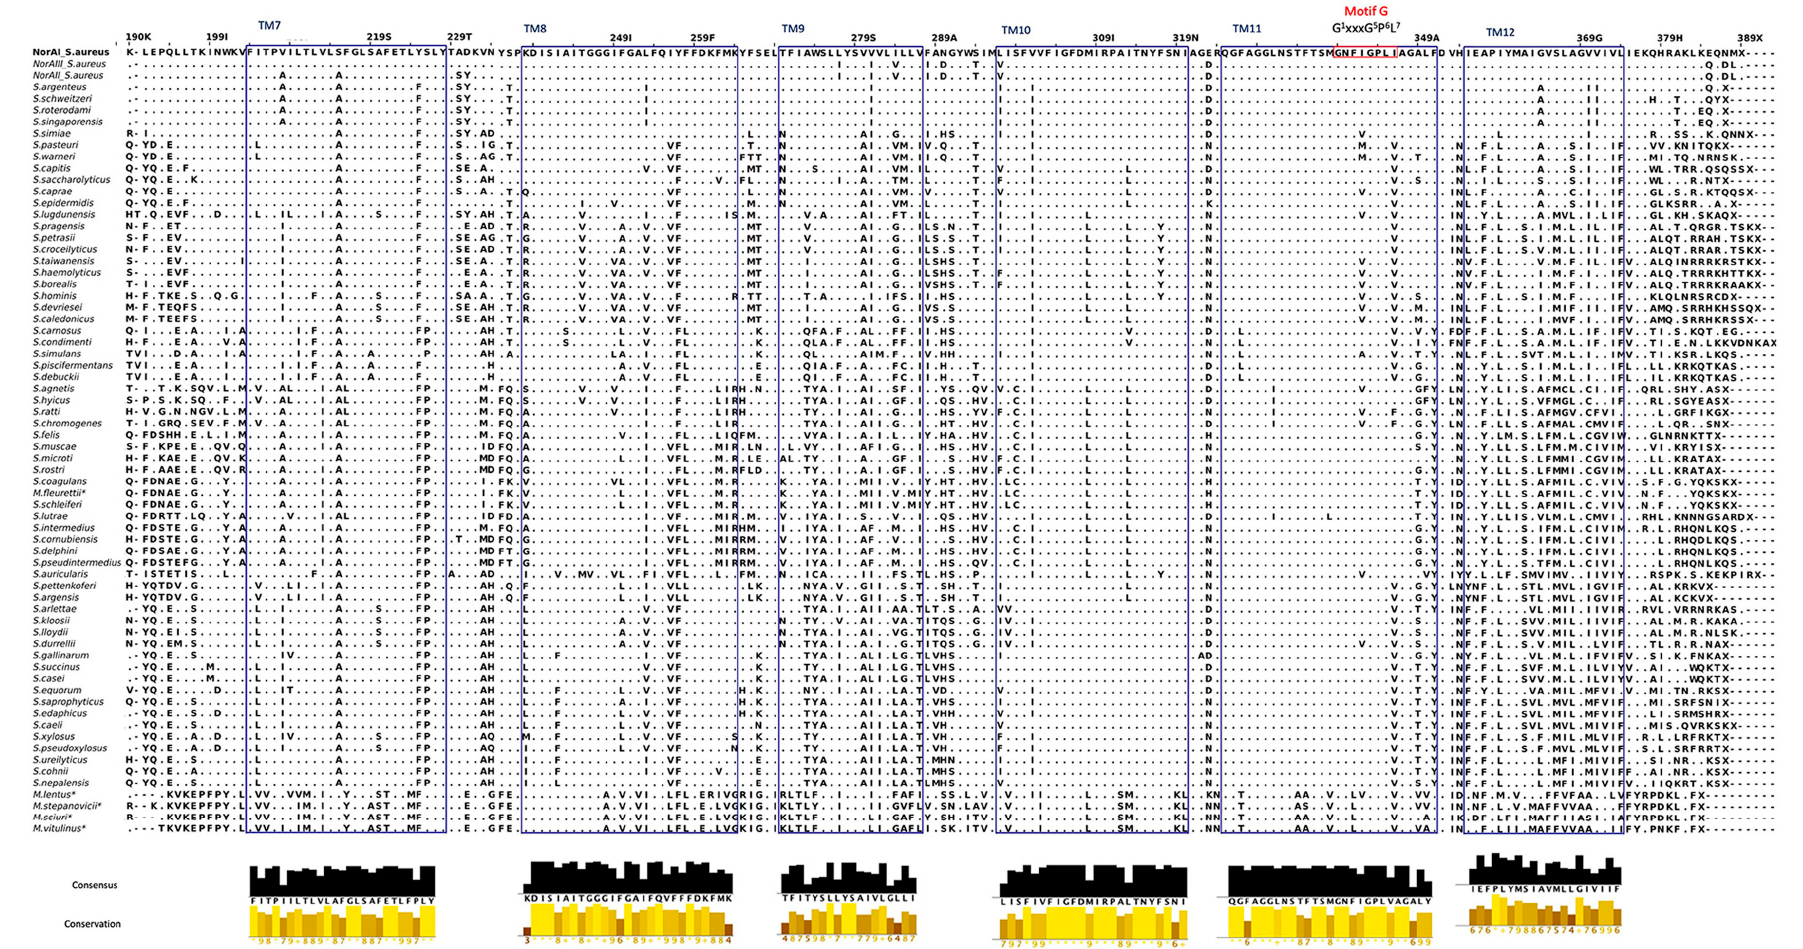
Figure 2. Multiple alignment of NorA polypeptide sequences derived from S. aureus alleles norAI [2], norAII [17], and norAIII [18] and from the norA sequences identified for other Staphylococcus species. Blue boxes correspond to the transmembrane segments (TMS) of NorA predicted by Brawley et al. [28] and red boxes to the MFS conserved motifs predicted by Paulsen et al. [25]. Consensus and conservation tracks are displayed for each of the TMS identified. Consensus histogram (black) reflects the percentage of the modal residue per column (‘+’ denotes non-conserved residues). Conservation histogram (yellow) reflects conservation of the physicochemical properties (‘*’ absolutely conserved residues, ‘+’ physicochemical properties conserved; less conserved positions are shown in darker colors with decreasing score